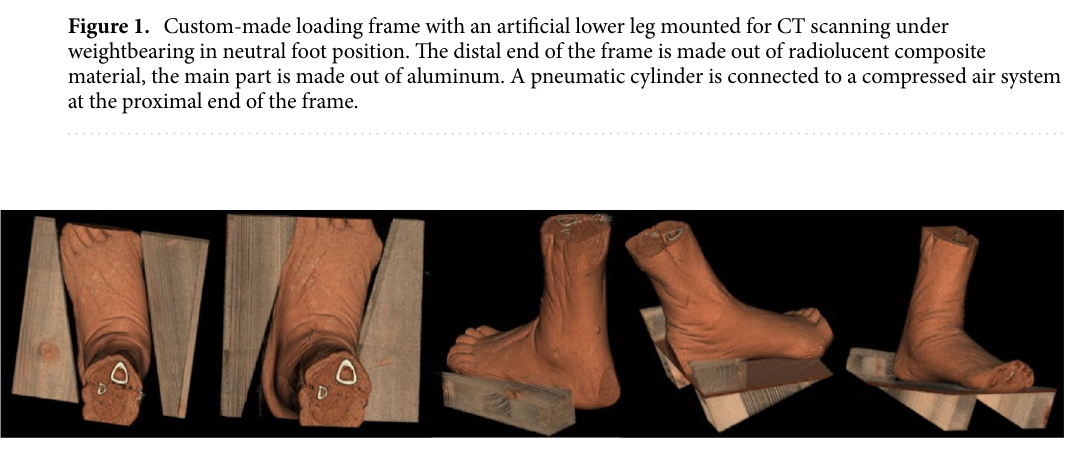
Figure 2. Wooden shanks used to maneuver the specimens in five foot positions in the loading frame during CT scanning; left to right: 15° external rotation, 15° internal rotation, neutral position, 20° plantar flexion, 20° dorsal flexion. The exemplified images are processed via volume rendering using Mimics Innovation Suite (Materialise, Leuven,